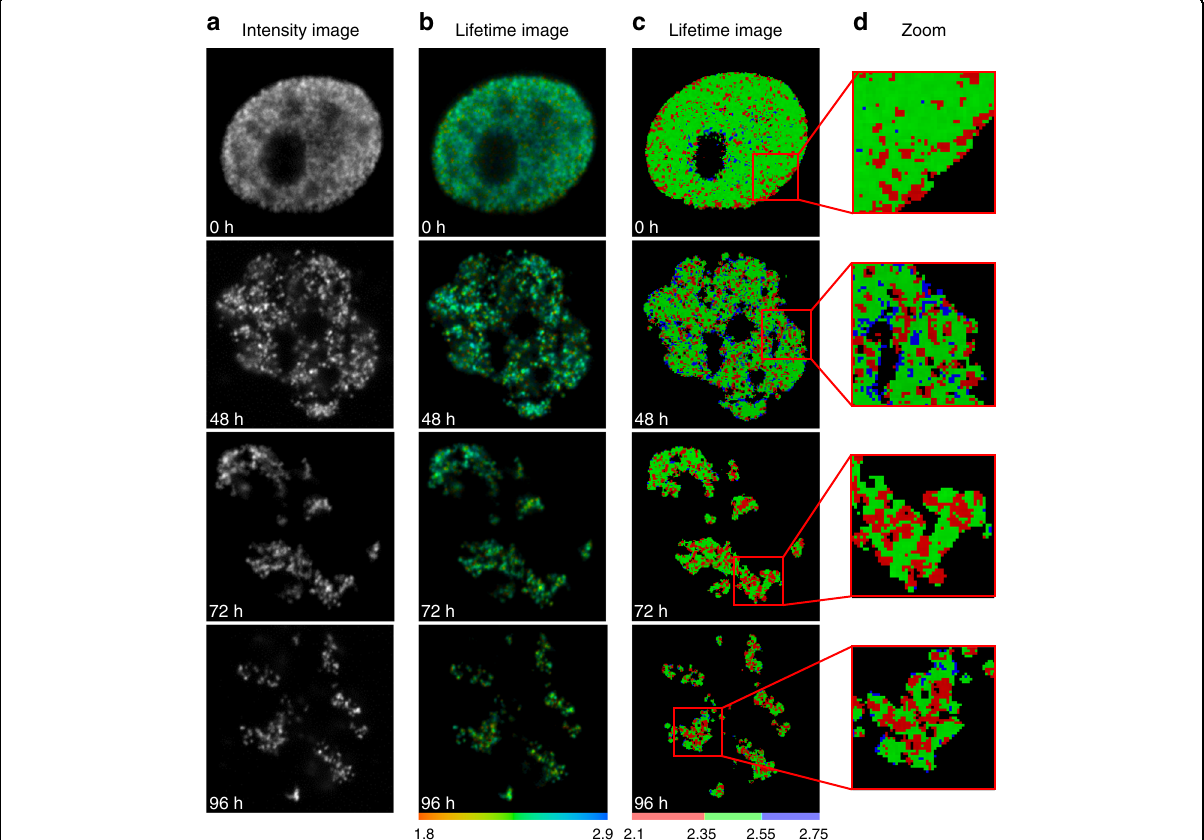
Fig. 2 FLIM imaging of labeled chromosome territories. Synchronized in early S-phase cells were pulse-labeled with BrdU and chased through subsequent cell cycles to yield segregation of labeled chromosome territories. Representative fl uorescence intensity ( a ), continuous ( b ), and discrete ( c , d ) fl uorescence lifetime images are shown. See Fig. S5 for additional